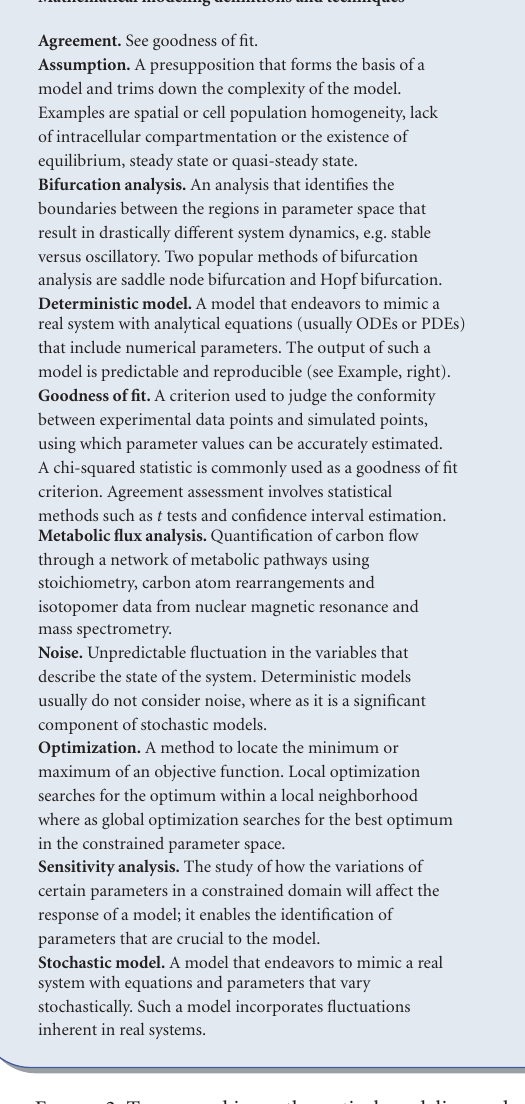
Figure 2: Terms used in mathematical modeling and an example of a simple (deterministic) mathematical